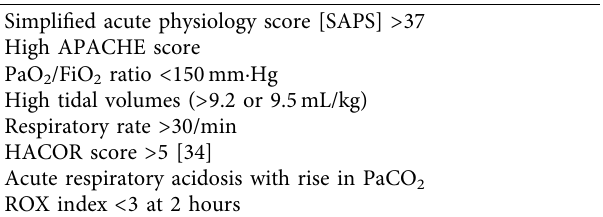
Table 3: Indicators of NIV